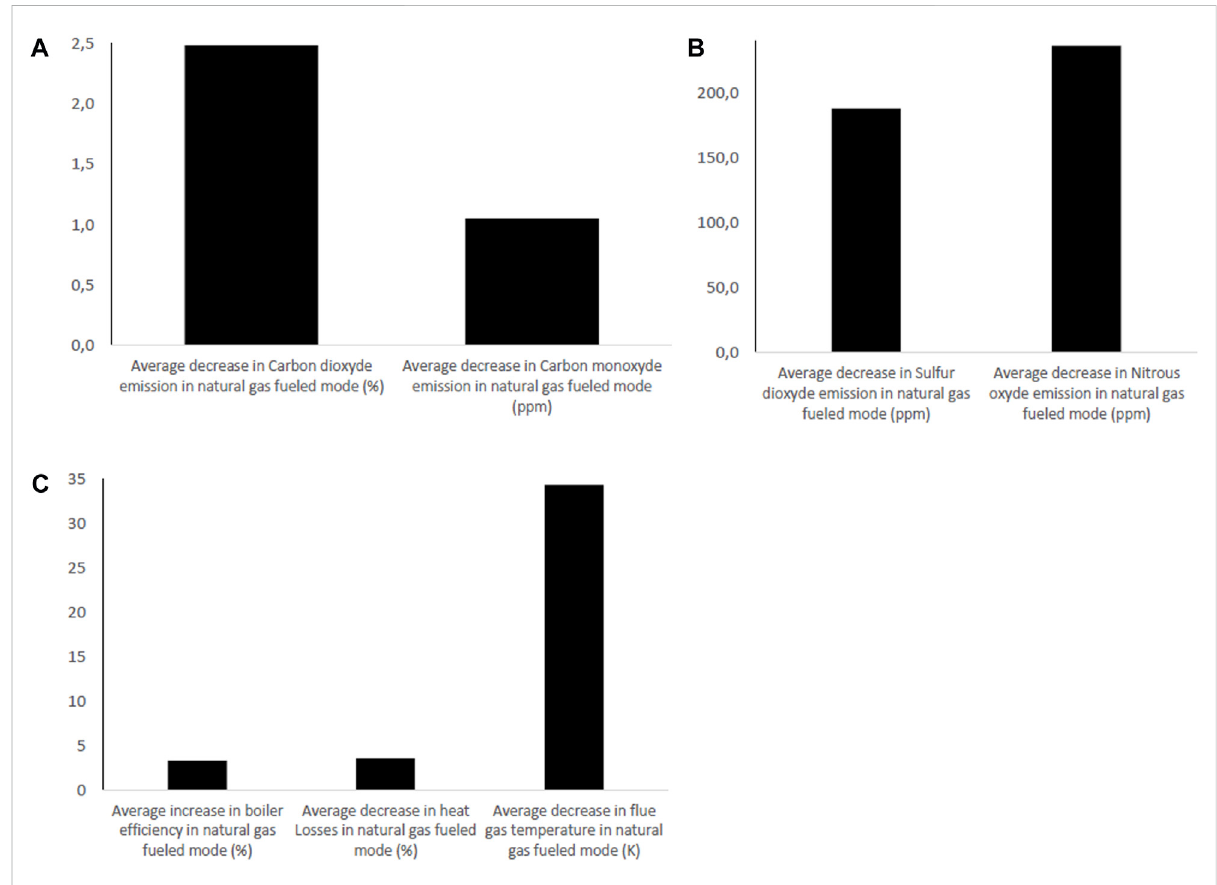
FIGURE 14 Amelioration of environmental and energetic parameters in natural gas fi red mode: (A) carbon dioxide and carbon monoxide emission, (B) sulfur dioxide and nitrous oxide emission, (C) thermal ef fi ciency, heat losses, fl ue gas